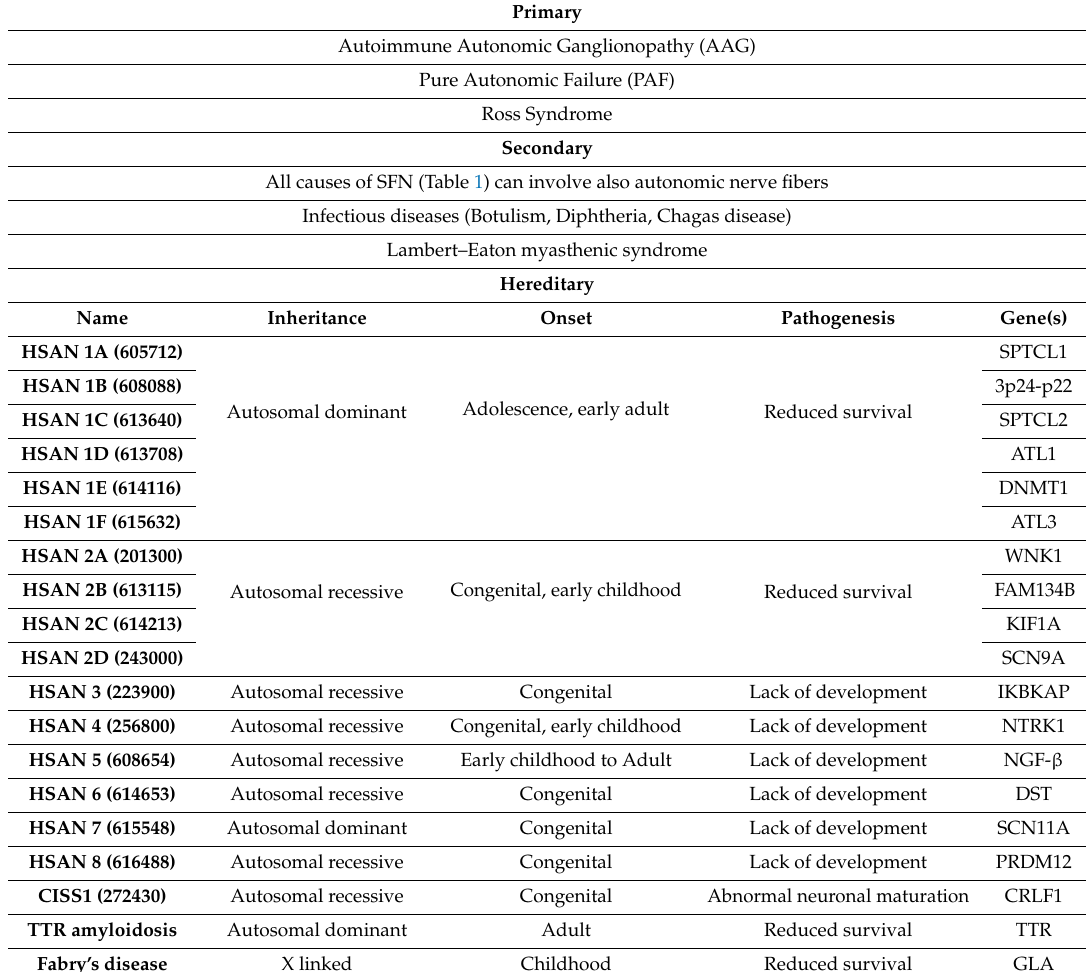
Table 2. Autonomic